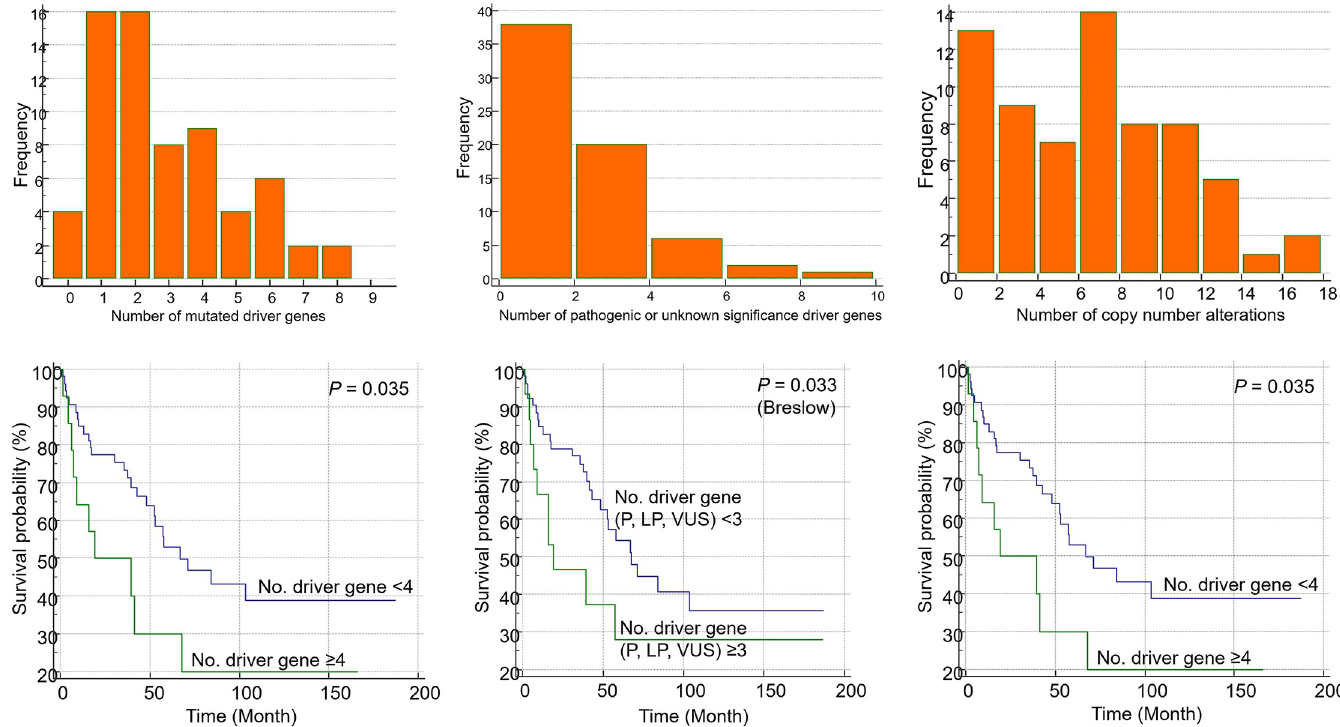
Fig 7. Distribution of the number of mutated driver genes in each patient. Distribution plots for the total number of (A) driver mutations, (B) selected mutations with variants of unknown significance, likely pathogenic, and pathogenic according to the ACMG guideline, and (C) copy number variations in each patient. Kaplan- Meier plots revealed that patients with (D) > 5 gene variants, (E) > 4 selected gene mutations, and (F) > 5 copy number variations exhibited poor overall survival.